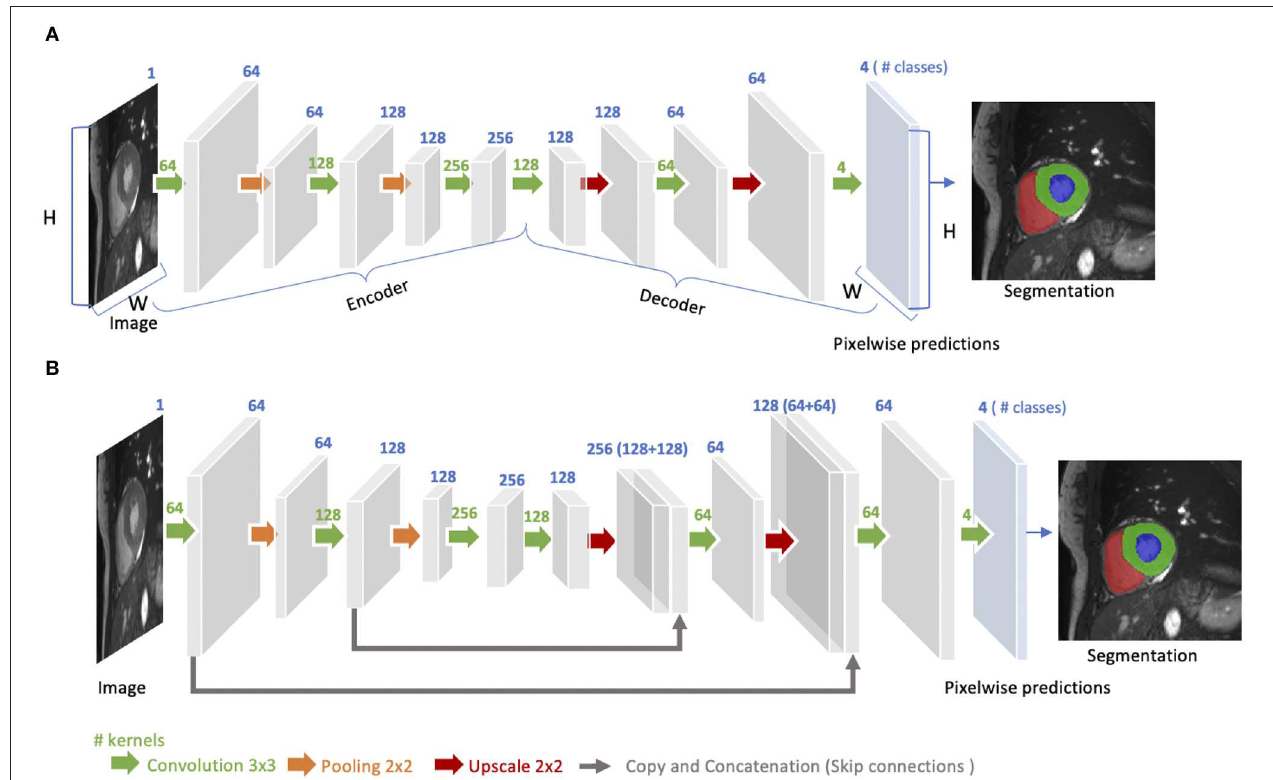
FIGURE 4 | (A) Architecture of a fully convolutional neural network (FCN). The FCN first takes the whole image as input, learns image features though the encoder, gradually recovers the spatial dimension by a series of upscaling layers (e.g., transposed convolution layers, unpooling layers) in the decoder and then produce 4-class pixel-wise probabilistic maps to predict regions of the left ventricle cavity (blue region), the left ventricular myocardium (green region) and the right ventricle cavity (red region) and background. The final segmentation map is obtained by assigning each pixel with the class of the highest probability. One use case of this FCN-based cardiac segmentation can be found in Tran (24). (B) Architecture of a U-net. On the basis of FCN, U-net adds “skip connections” (gray arrows) to aggregate feature maps from coarse to fine through concatenation and convolution operations. For simplicity, we reduce the number of downsampling and upsampling blocks in the diagram. For detailed information, we recommend readers to the original paper ( 49).